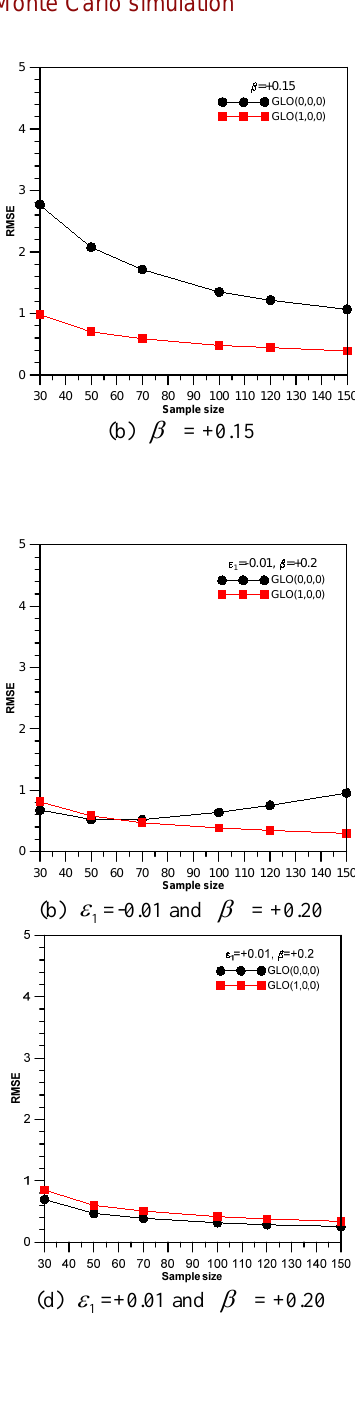
model. For the generated data by a stationary model, as the results, the errors of stationary models were generally small- est compared to nonstatnioary model. For the generated data by a nonstationary model, oppositely, the errors of a nonsta- tionary model were smaller than those of a stationary model over 70 or 100 of sample